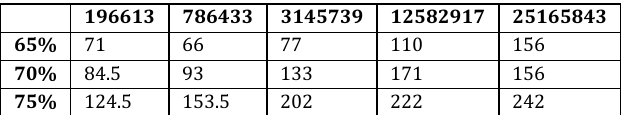
Fig. 9. Amortized collision, Murmur, long jump, string length=13 * all lines are overlapped